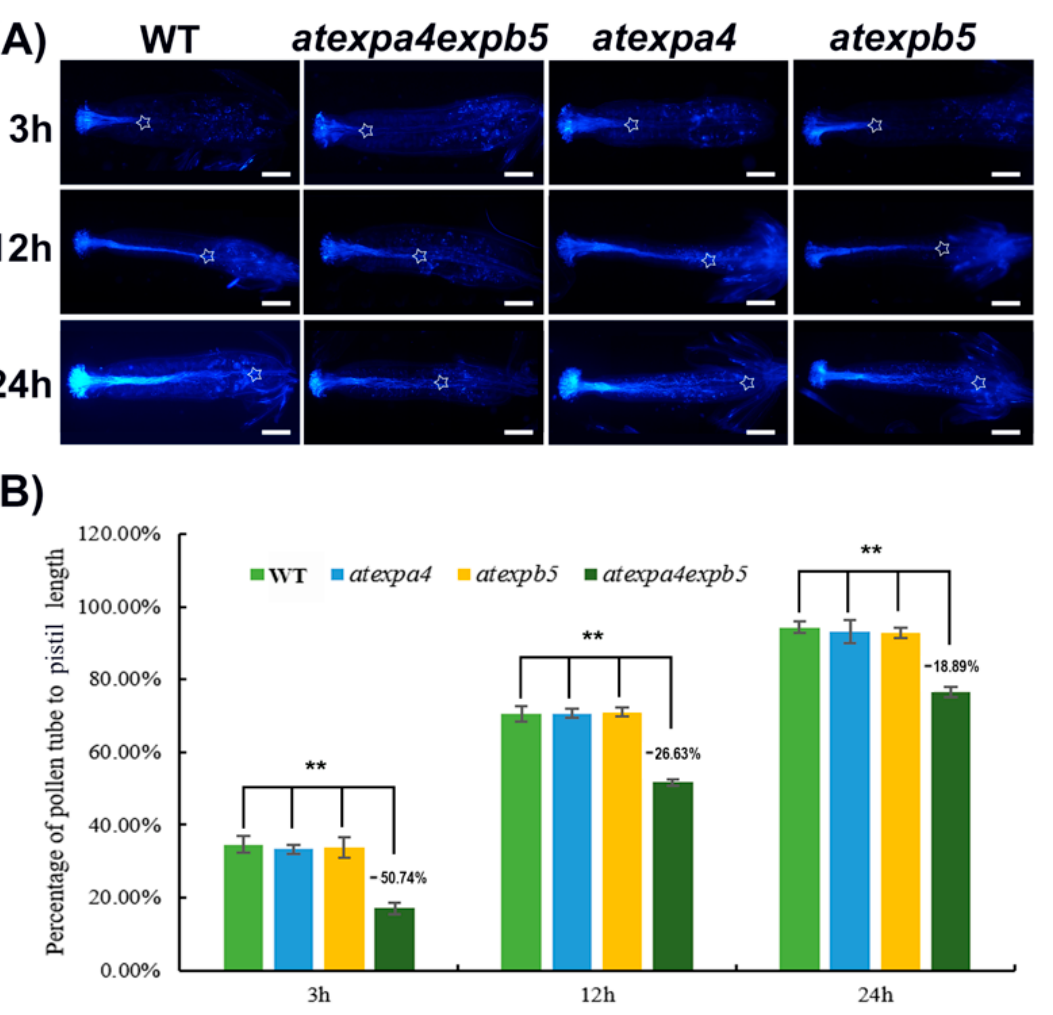
Figure 4. AtEXPA4 and AtEXPB5 are involved in pollen tube growth. ( A ), Aniline blue staining of pollen tubes at 3 h, 12 h, and 24 h after pollination in single and double mutants, hours (h). Asterisks show positions where pollen tubes arrive, scale bars, 400 μ m. ( B ), the percentage of pollen tube to pistil length in ( A ). Values are means, error bars are SD, n = 12 pistils per replicate, three biological replicates, t -tests as ** P < 0.01. Table 1. Segregation data from self-crossing of heterozygous F 1 double mutants [ expa4 (+/ − ) expb5 (+/ − )]. Genotype of F 2 Plants